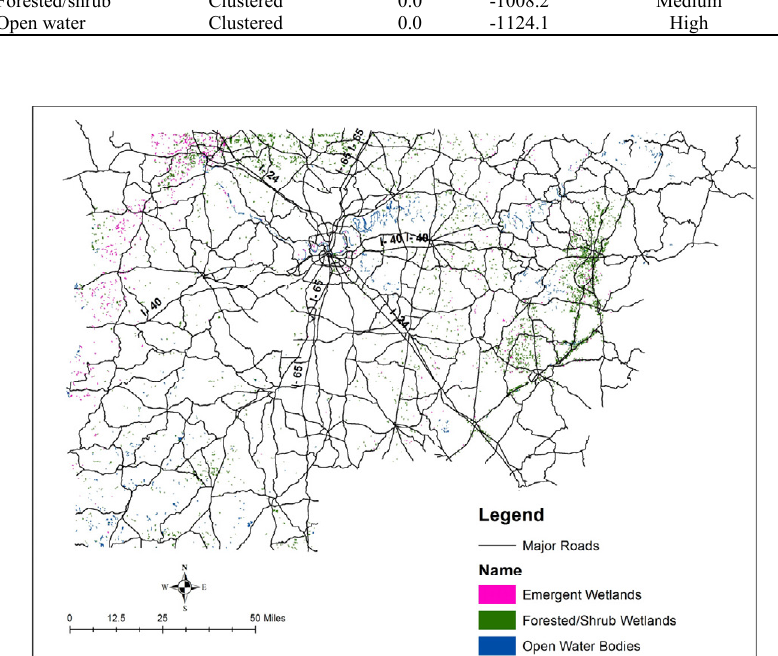
Fig. 5: Potentially vulnerable inland wetlands in middle Tennessee as a result of human and natural stressors by the year 2080